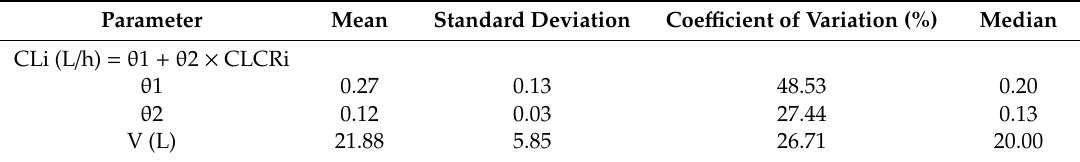
Table 2. Parameter estimates of meropenem for the final covariate one-compartment population pharmacokinetic